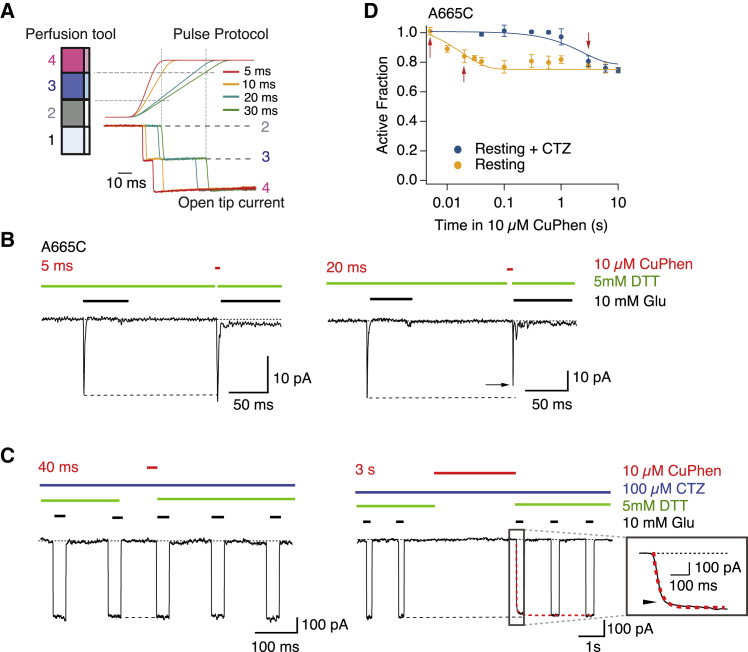
Rapid resting state desensitization. (A) Using the four-barrel fast perfusion system and switching from barrel 2 to 4, we applied oxidizing conditions for intervals as brief as 5 ms, with a voltage ramp command to the piezo lever (right panel). The open tip junction current shows that the pipette spends between 5 and 30 ms in the third barrel outflow (blue). Dashed lines indicate switch times for the 20-ms exposure. (B) Patch-clamp experiments showing Cu:Phen (10 μM) exposures of 5 ms (left panel) and 20 ms (right panel) for the mutant A665C in the resting state. Arrows indicate reduction of the current after modification. (C) Patch-clamp experiments show applications of Cu:Phen 10 μM for 40 ms (left panel) and 3 s (right panel) to. the mutant A665C in resting state with CTZ (100 μM). The inset shows the current profile during recovery; the arrow indicates reduction of the current after trapping. (D) The AF of receptors after oxidization in the desensitized state (continuous lines, exponential fit) is plotted against the trapping interval. Arrows indicate intervals for the traces in (B and C). The probability of no difference between the AF after trapping in resting state without and with CTZ for A665C after 10 s of application of oxidizing conditions was 0.003 (n = 3–6 patches per point). To see this figure in color, go online.